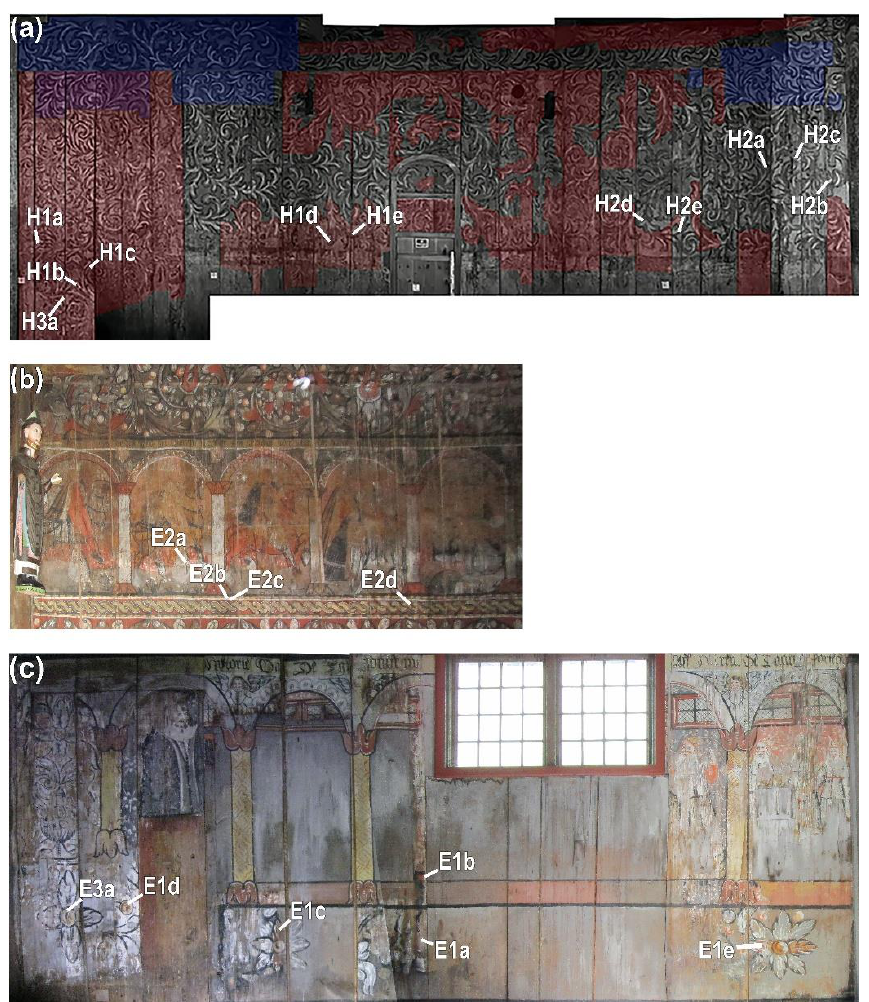
Figure 3. Maps of sampling points. ( a ) Heddal stave church, northern nave wall. Red denotes areas consolidated in 2009, whereas blue signifies areas of integrated wood and décor from the 1950s. ( b ) Eidsborg stave church, northern nave wall; ( c ) Eidsborg stave church, southern nave wall which was consolidated in 2007. Sample code and descriptions for both churches are compiled in Table 2. See Table S4 in supplementary material for sample area details. Treatment map from [8] was reproduced and modified with the permission of B. Wedvik, NIKU Rapport nr 121/2009.